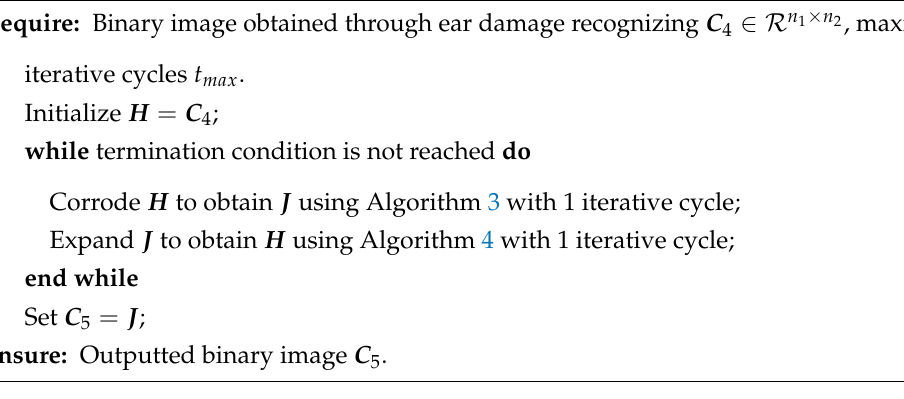
Figure 8. Outline of the complete method. Algorithm 6 Post-processing of ear damage